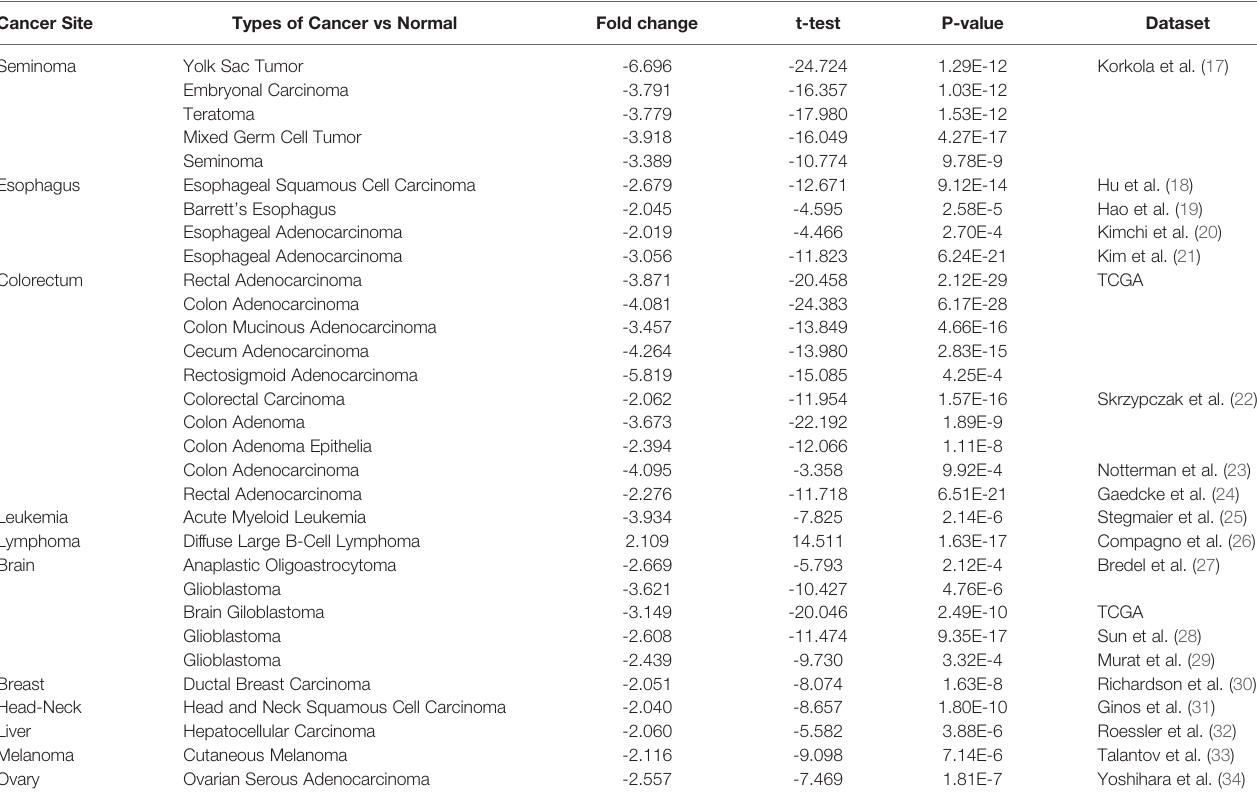
TABLE 1 | Datasets of PINK1 expression in pan-cancers. (ONCOMINE